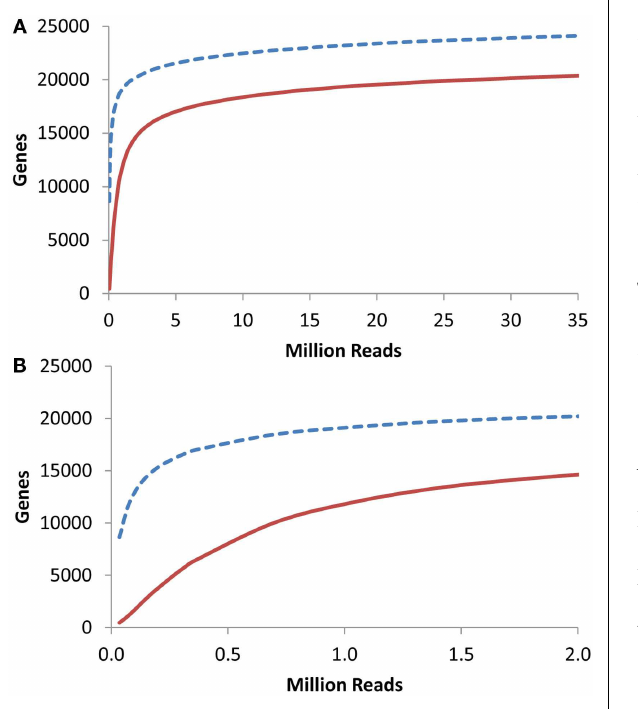
FIGURE 6 | Gene coverage in Arabidopsis RNAseq. Using a previous analysis of the Arabidopsis thaliana transcriptome via RNAseq, I plotted the number of genes identified with 1 (dashed blue line) or 10 (solid red lines) reads per gene in a given number of RNAseq reads. (A) Full plot. (B) . Close up of plot in (A)